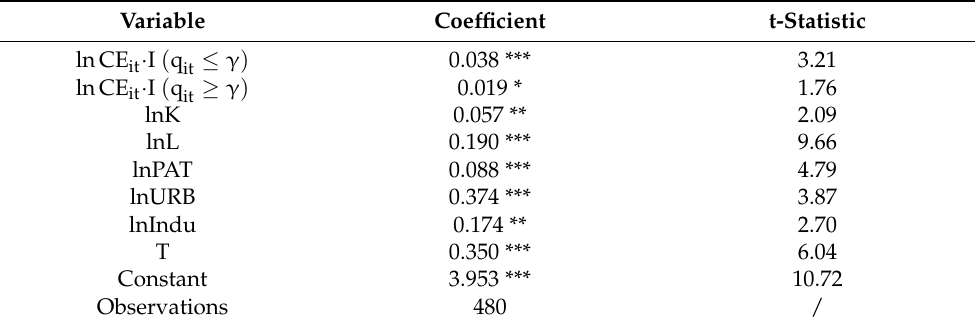
Table 6. Regression results of 24 provinces after excluding special